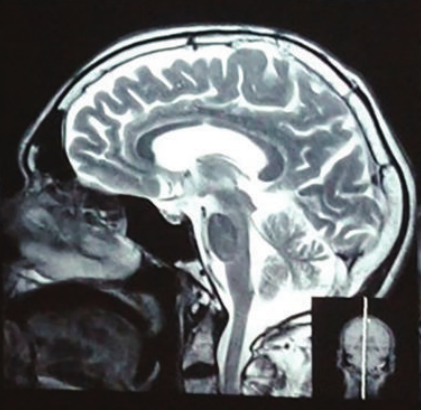
Figure 1: Bilateral facial atrophy seen.